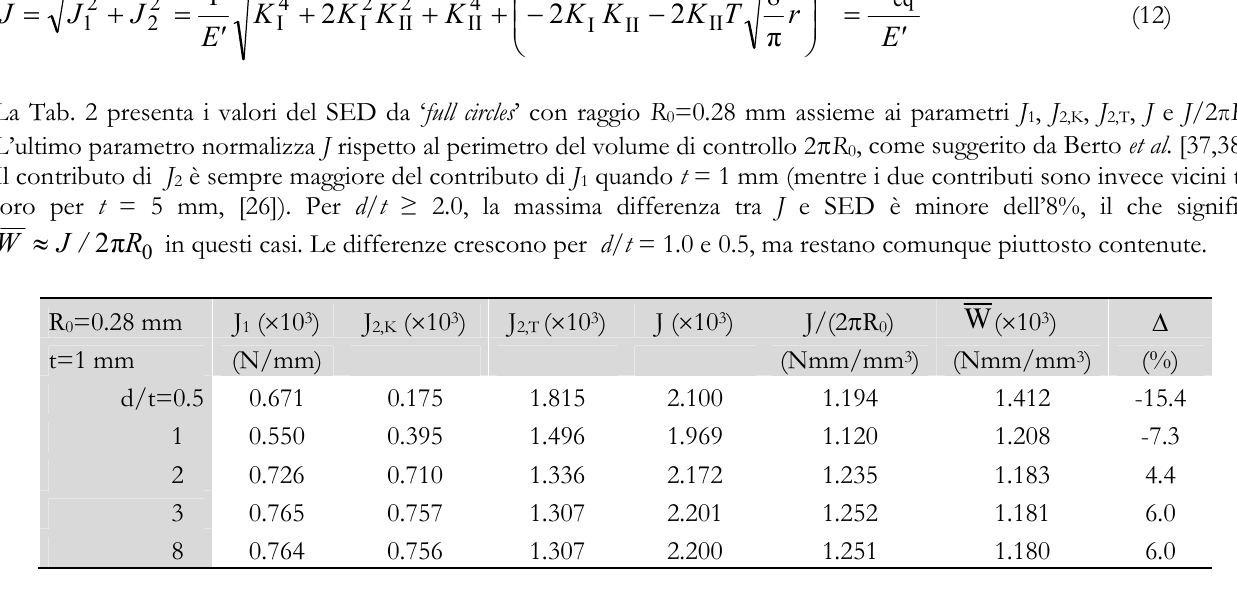
Tabella 2: Giunti a cordone continuo saldati a sovrapposizione, F/(t  1)=10 MPa (da Lazzarin, Berto e Radaj, 2009